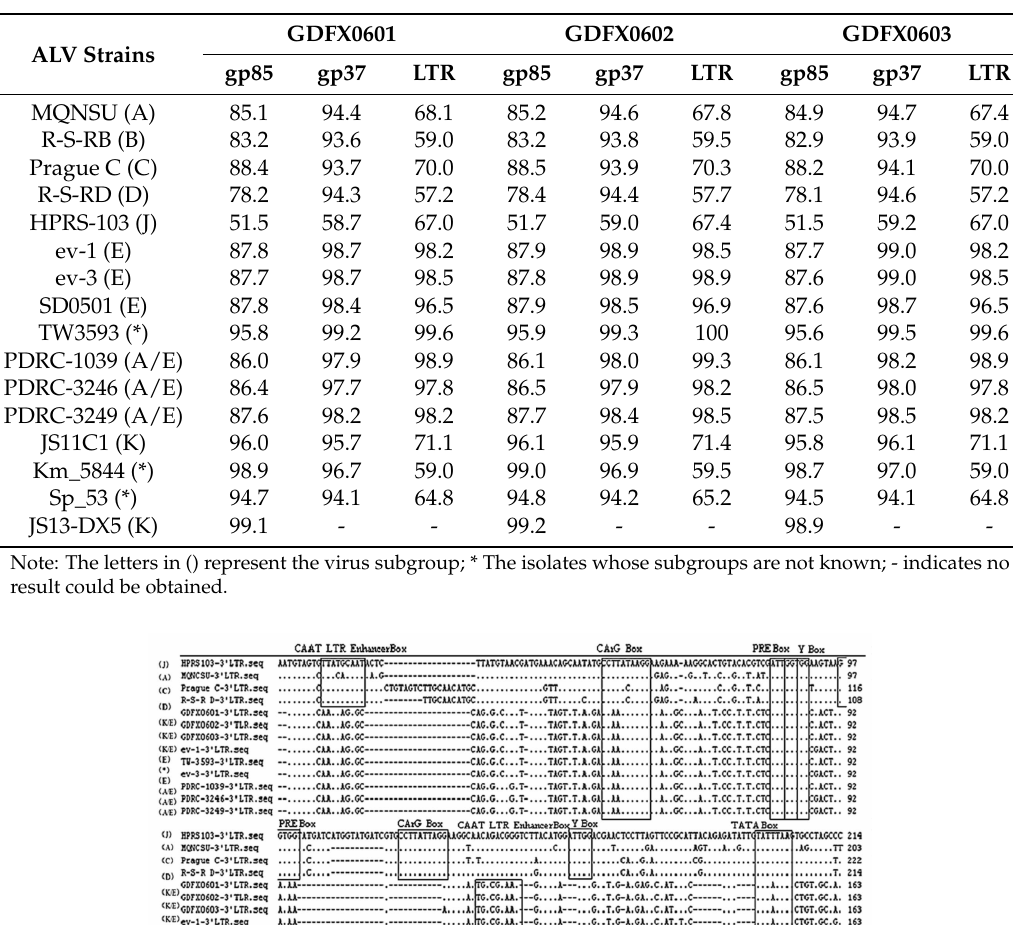
Table 3. Homology of nucleotide sequences of the long terminal repeat (LTR), gp85, and gp37 genes between the 3 isolates and other reference strains.